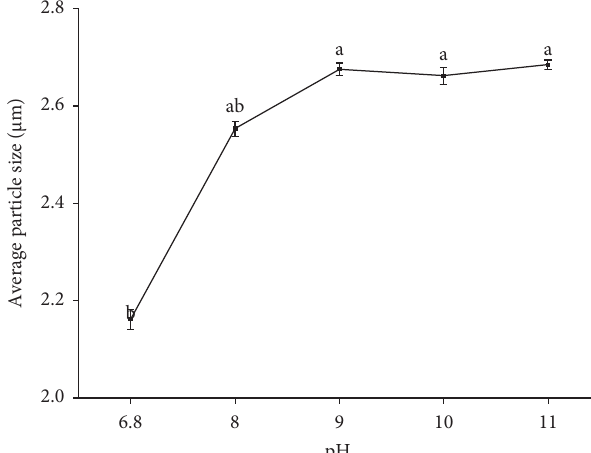
Figure 3: Effect of different pH values on the average particle size of peanut oil body (pH range of